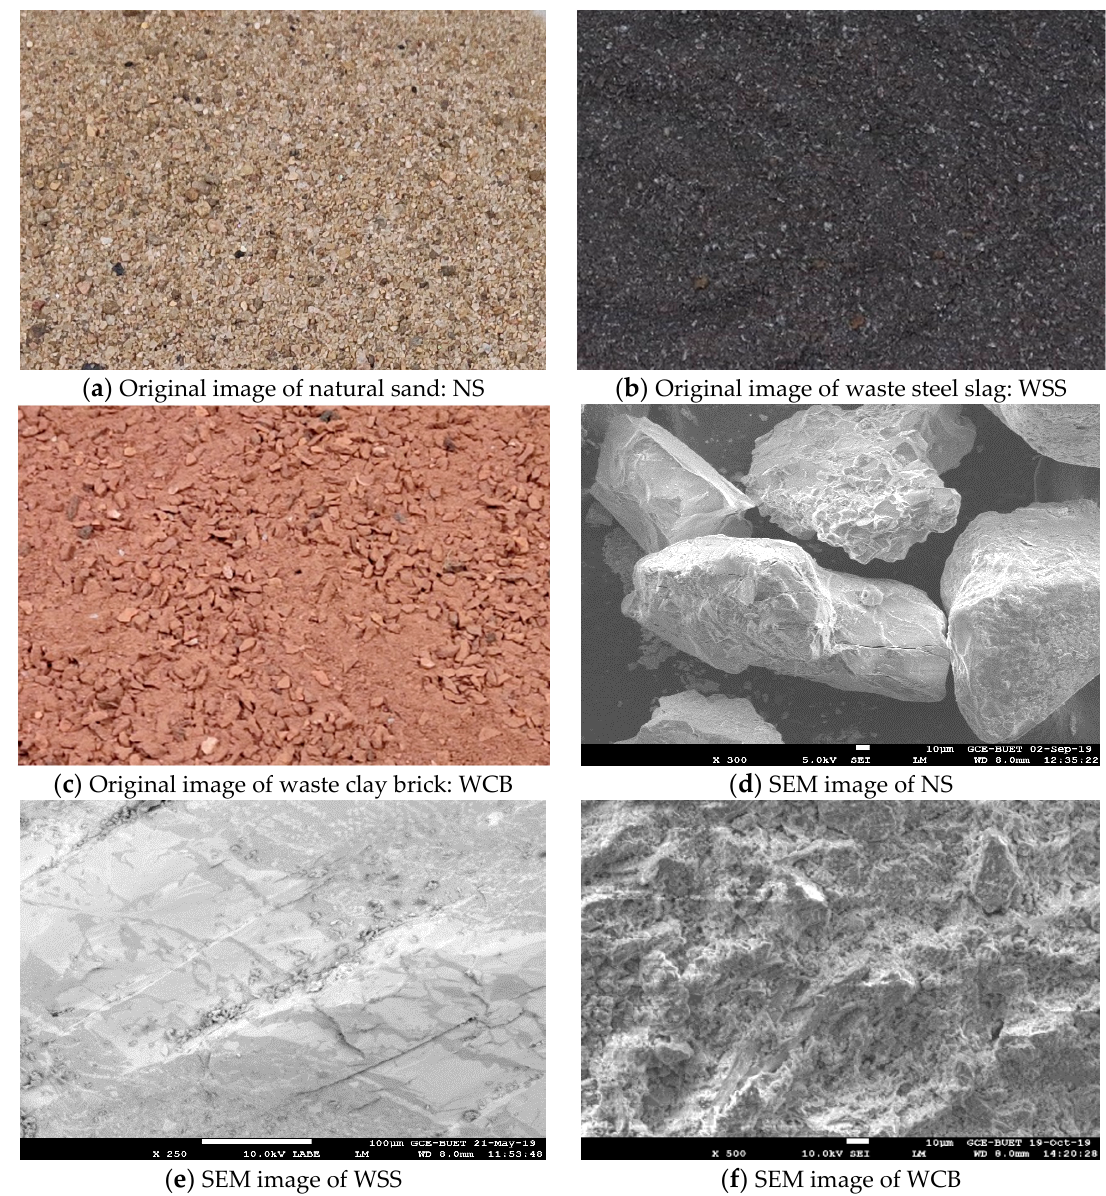
Figure 1. Pictures of natural sand—NS ( a ), waste steel slag—WSS ( b ) and waste clay brick—WCB ( c ), and SEM images of NS ( d ), WSS ( e ) and WCB ( f ), respectively.